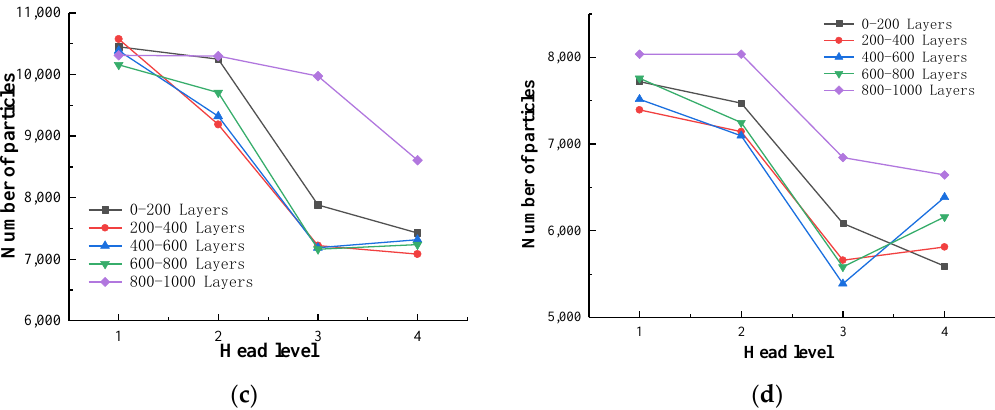
Figure 14. Variation in the number of fine particles percolated with the 30% fine content. ( a ) Particle size: 0 – 10 µm; ( b ) Particle size: 10 – 20 µm; ( c ) Particle size: 20 – 40 µm; ( d ) Particle size: 40 – 75 µm.